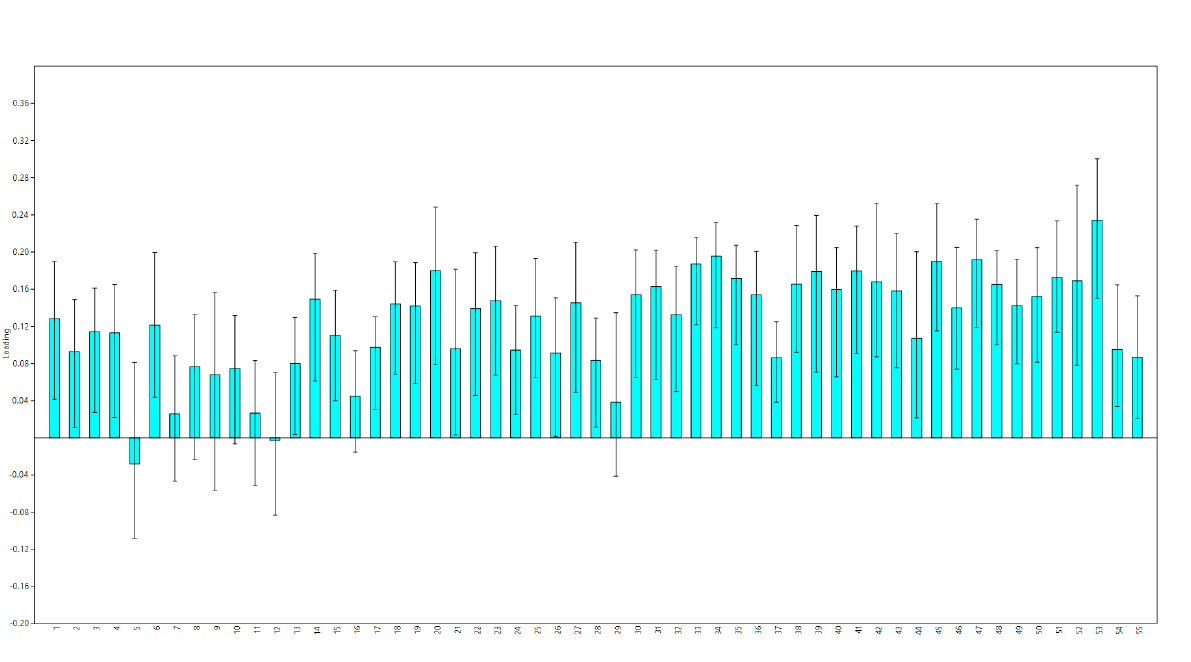
Figure A1 Bootstrap analysis of correlations between the first principal component (PC1) and the original variables.